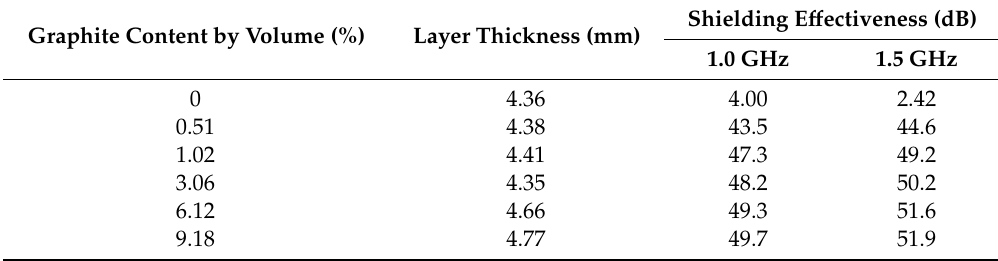
Table 2. Shielding e ff ectiveness of tested samples containing petroleum coke. Graphite Content by Volume